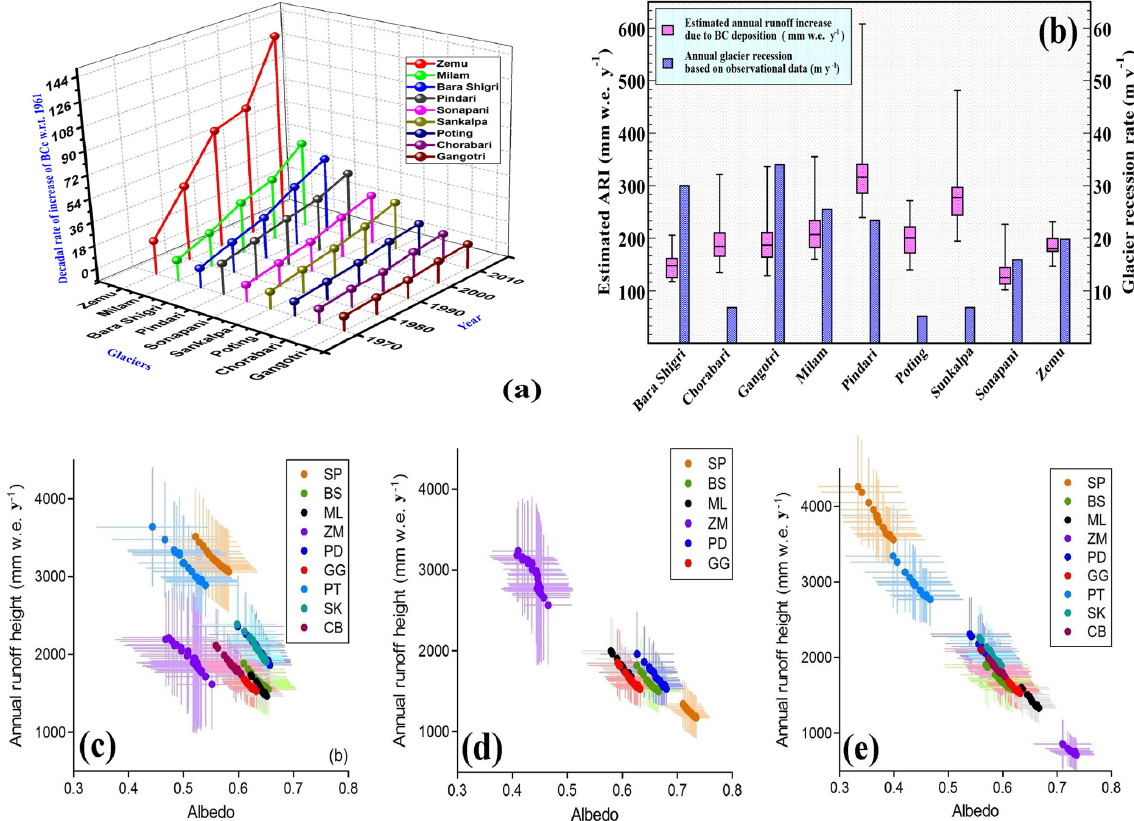
Figure 3. (a) Glacierwise decadal trend (1961–2010, percent rate of increase with respect to 1961) of BC c based on atmospheric BC concentration (µgm − 3 ) modeled over the glacier using SPRINTARS, (b) estimated increase in annual glacier runoff (mmw.e.y − 1 ) shown as box-and-whisker plot and average yearly recession (my − 1 ) for the nine glaciers, (c) simulated summer mean albedo and annual runoff depth of glaciers, and those of sensitivity analysis for (d) a single glacier hypsometry at different ERA-Interim grids and (e) different glacier hypsometries at a single ERA-Interim